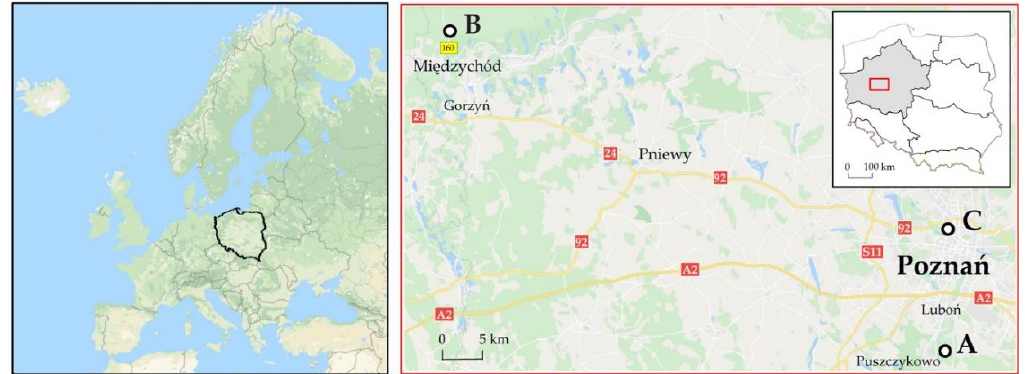
Figure 1. The location of the investigated Tilia cordata Mill. trees in Greater Poland–Pomerania natural forest regions (grey area). ( A )—cambial age: 50 years old; ( B )—130 years old; ( C )—100 years